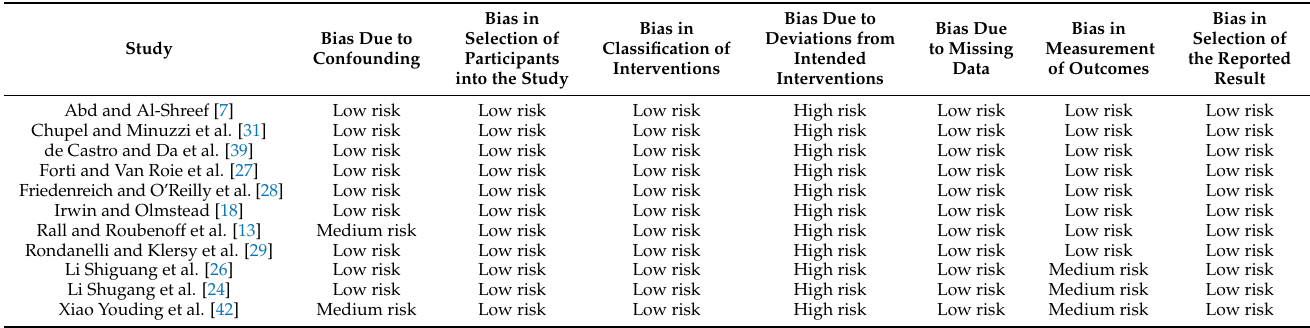
Table 2. Results of quality evaluation of included self-controlled trial literature.